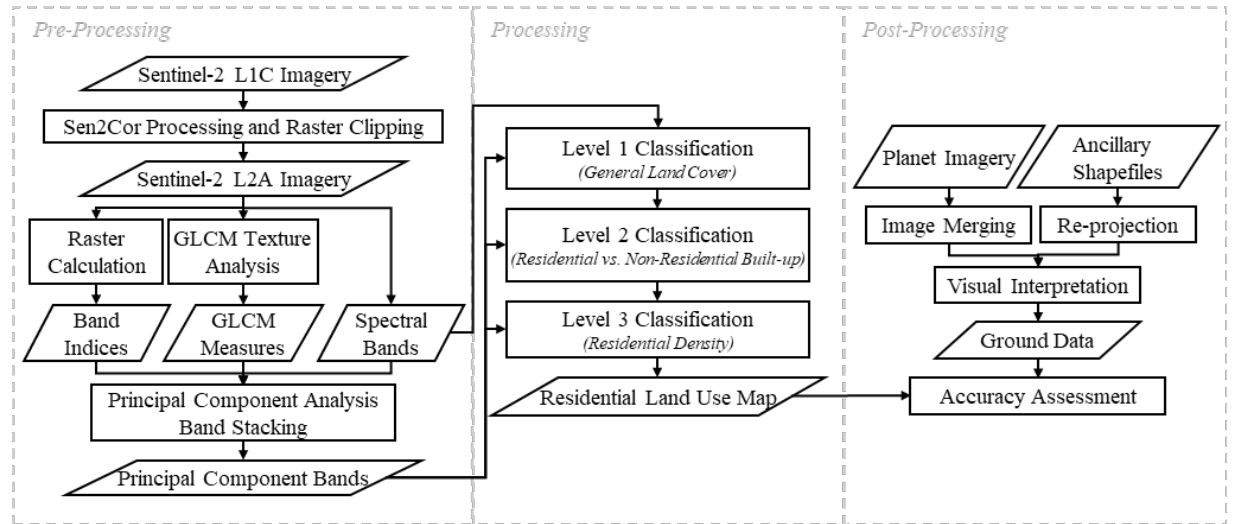
Figure 2. General workflow of the study. Classification of the image data set is carried out using Support Vector